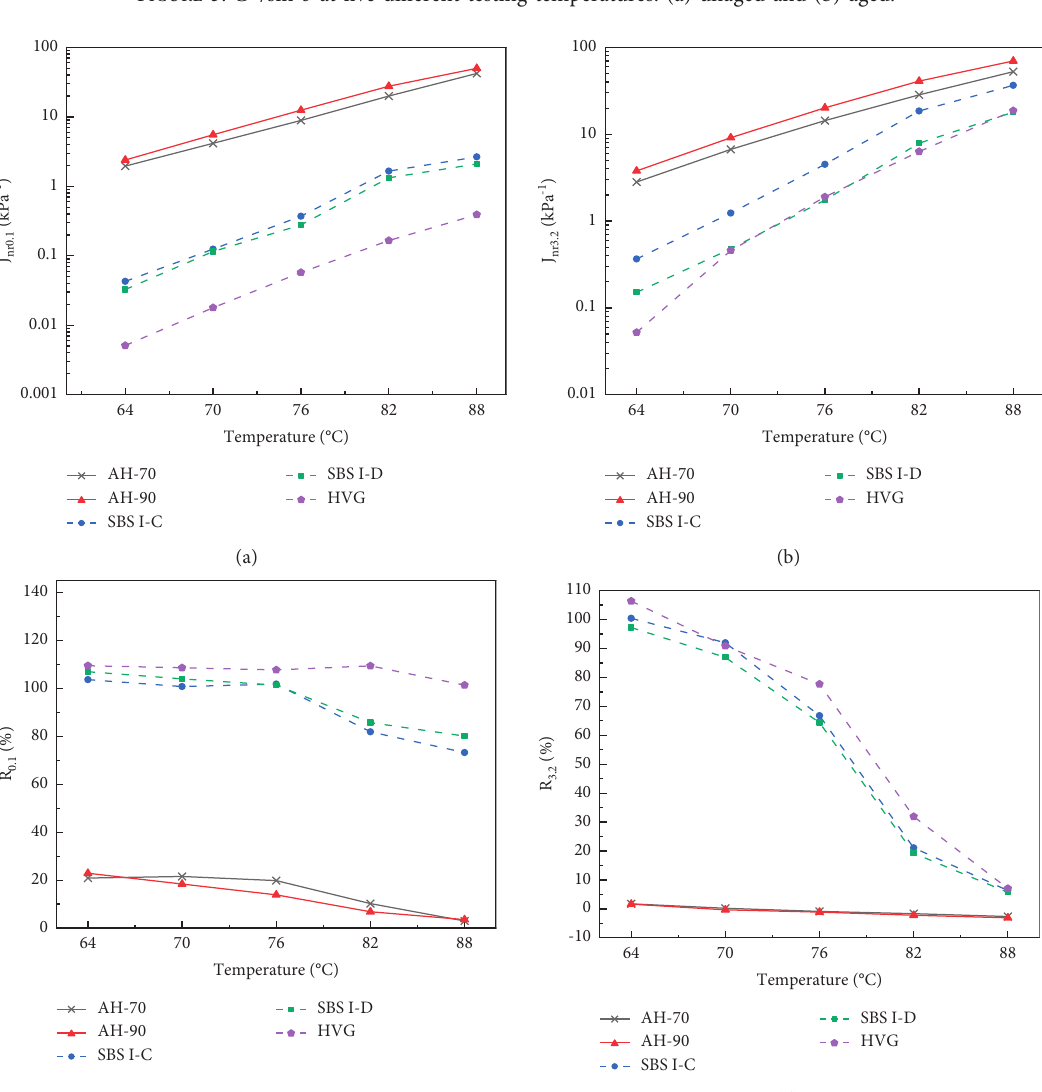
Figure 3: G ∗ /sin δ at five different testing temperatures: (a) unaged and (b)